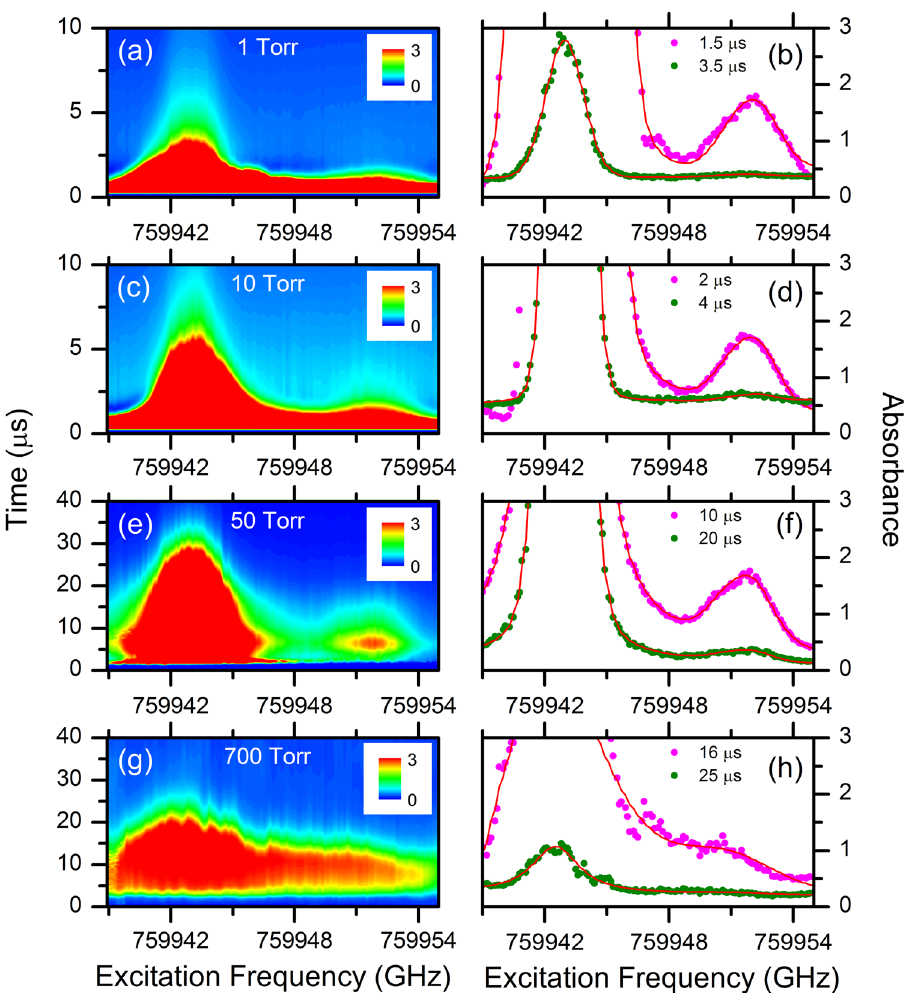
Figure 4. Time-resolved absorption spectra of uranium. TRAS (left) and spectral fits at indicated times (right) for NU sample. Ar pressure is ( a , b ) 1 Torr, ( c , d ) 10 Torr, ( e , f ) 50 Torr, and ( g , h ) 700